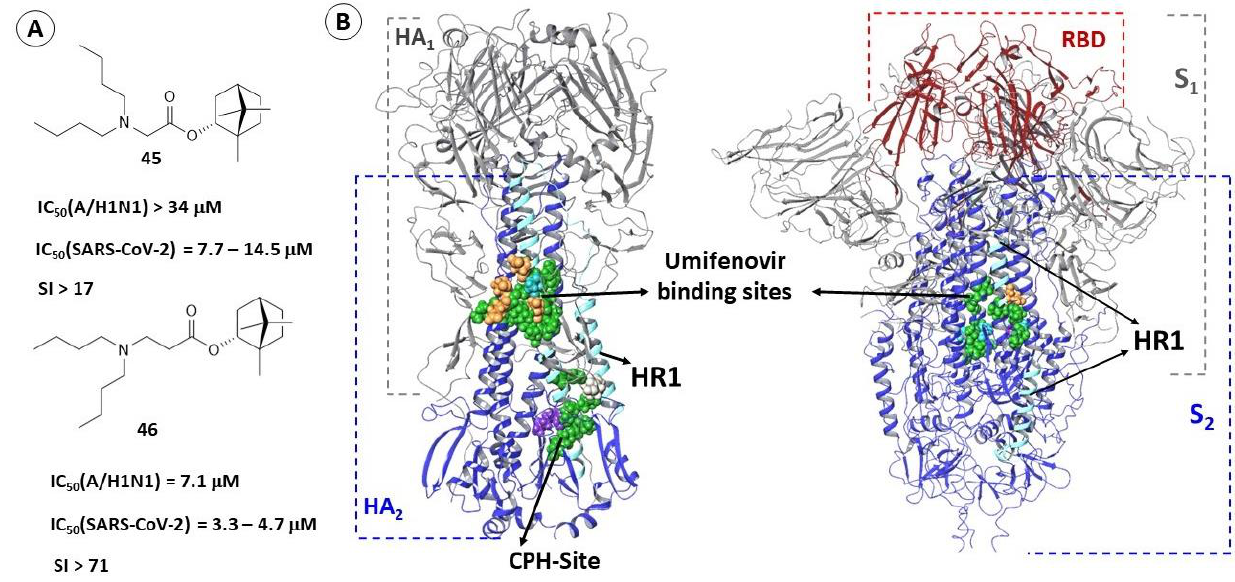
Figure 16. Derivatives of (-)-borneol ester are inhibitors of HA and S-protein. Structures of derivatives of (-)-borneol esters ( A ): the ranked value of IC 50 depends on the inhibitory ability against different strains of the virus (adapted from [116]). A comparison ( B ) of the pharmacophoric profile of the binding sites of the stem part of HA 2 and S 2 : the secondary structure of the heptad repeat (HR1) (a. a. 910 – 985) in one protein protomer is shown in blue. Hydrophobic amino acids are shown in green and positively and negatively charged amino acids are in purple and light orange, respectively. Polar amino acids are shown in blue.